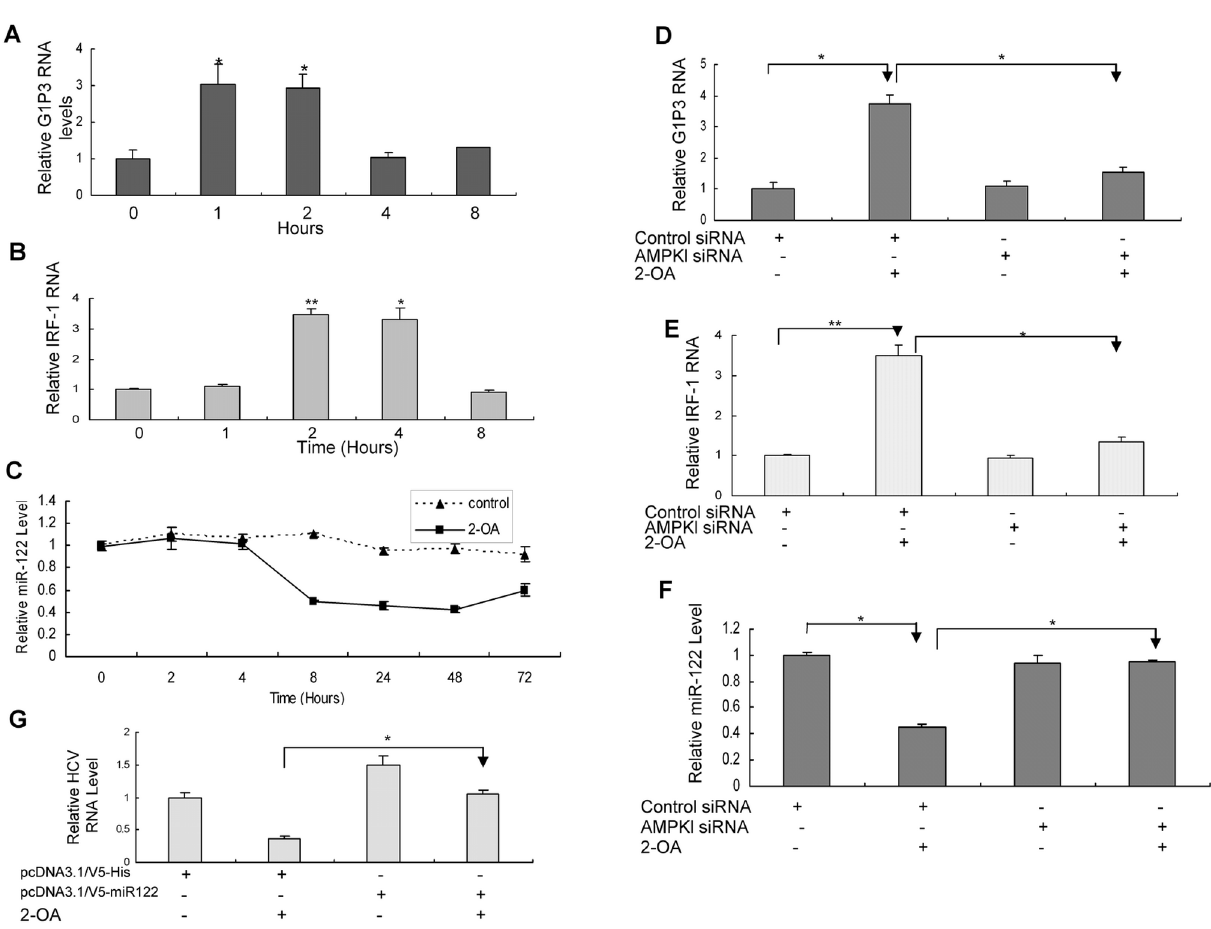
Figure 5. 2-OA induces ISGs and inhibits the expression of miR-122 through activated AMPK. ( A ) / ( B ) 2-OA induces G1P3 ( A ) and IRF-1 ( B ) in HCV-infected Huh7.5. Virus-infected cells were incubated with 100 m M 2-OA for different time periods. G1P3 ( A ) or IRF-1 ( B ) RNA was detected with real-time PCR. The expression of G1P3 or IRF-1 was normalized with GAPDH. The data represented the means of 3 different experiments. ( C ) 2- OA suppresses miR-122 expression in HCV-infected Huh7.5 cells. Virus-infected hepatocytes were treated with 100 m M 2-OA for different time periods. MiR-122 was detected with real-time PCR. The expression of miR-122 was normalized with GAPDH. ( D ) / ( E ) Knockdown of AMPK by AMPK siRNA abrogates the induction of G1P3 and IRF-1 by 2-OA. Virus-infected Huh7.5 cells pretransfected by AMPK siRNA or control siRNA were incubated with 100 m M 2-OA for 2 hours. G1P3 ( D ) or IRF-1 ( E ) RNA was detected with real-time PCR. The expression of G1P3 or IRF-1 was normalized with GAPDH. ( F ) Knockdown of AMPK by AMPK siRNA reverses the inhibition of miR-122 by 2-OA. HCV-infected Huh7.5 cells pretransfected by AMPK siRNA or control siRNA were treated with 100 m M 2-OA for 48 hours. MiR-122 was detected with real-time PCR. The expression of miR-122 was normalized with GAPDH. ( G ) MiR-122 overexpression reversed the antiviral effect of 2-OA. MiR-122 was overexpressed in HCV-infected cells and the cells were treated by 100 m M 2-OA for 48 hours. Total cellular RNA was isolated from the cells. HCV RNA was detected by real-time PCR analysis and normalized with